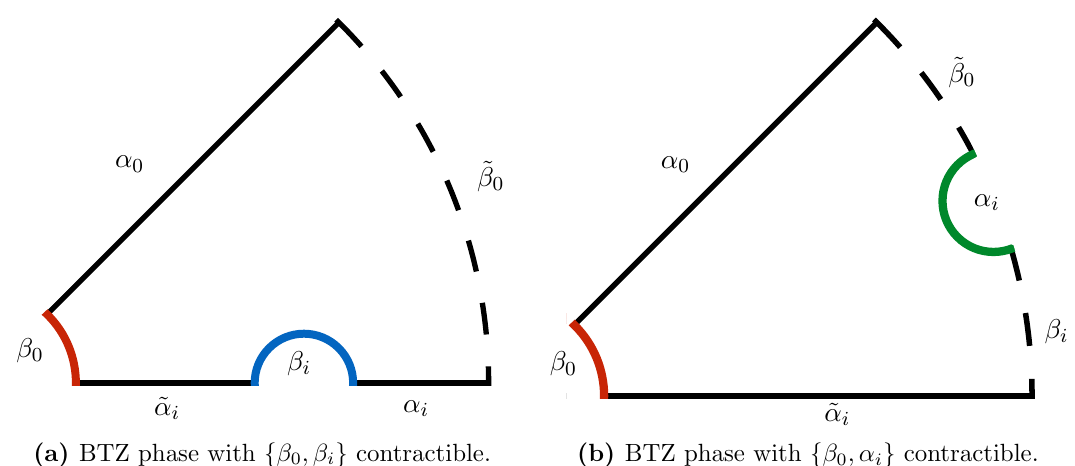
Figure 7 . A slice of the Schottky domains used to construct the two BTZ phases, reduced by the re(cid:13)ection symmetry in the x-axis, 2 (cid:25)=n rotational symmetry about the origin, and the inversion symmetry through the unit circle (dashed). Various boundary cycles are labeled in each